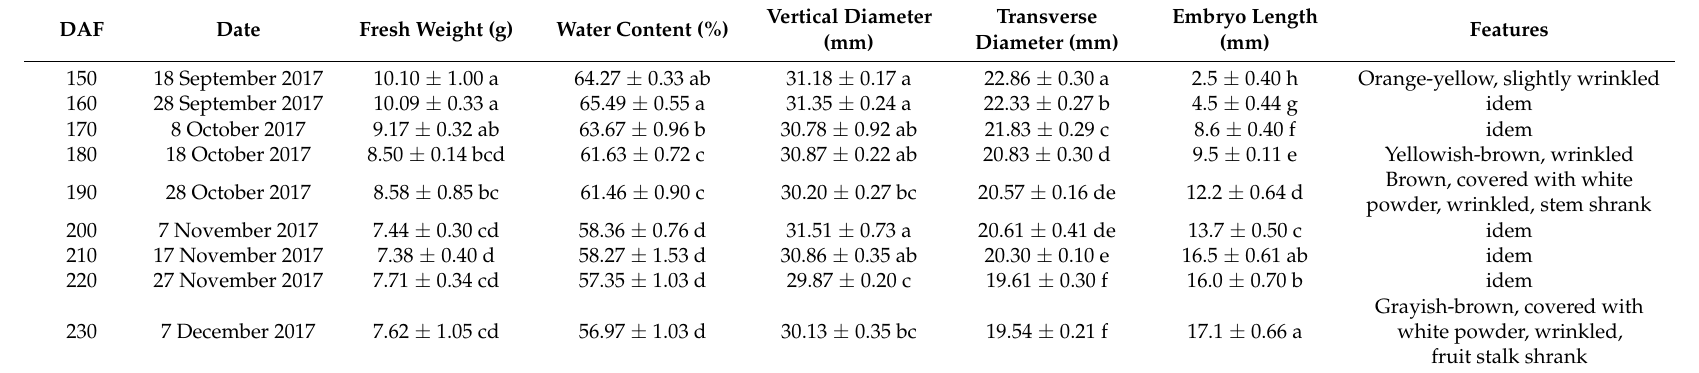
Note: the same lowercase letter does not differ significantly at the 0.05 probability level.